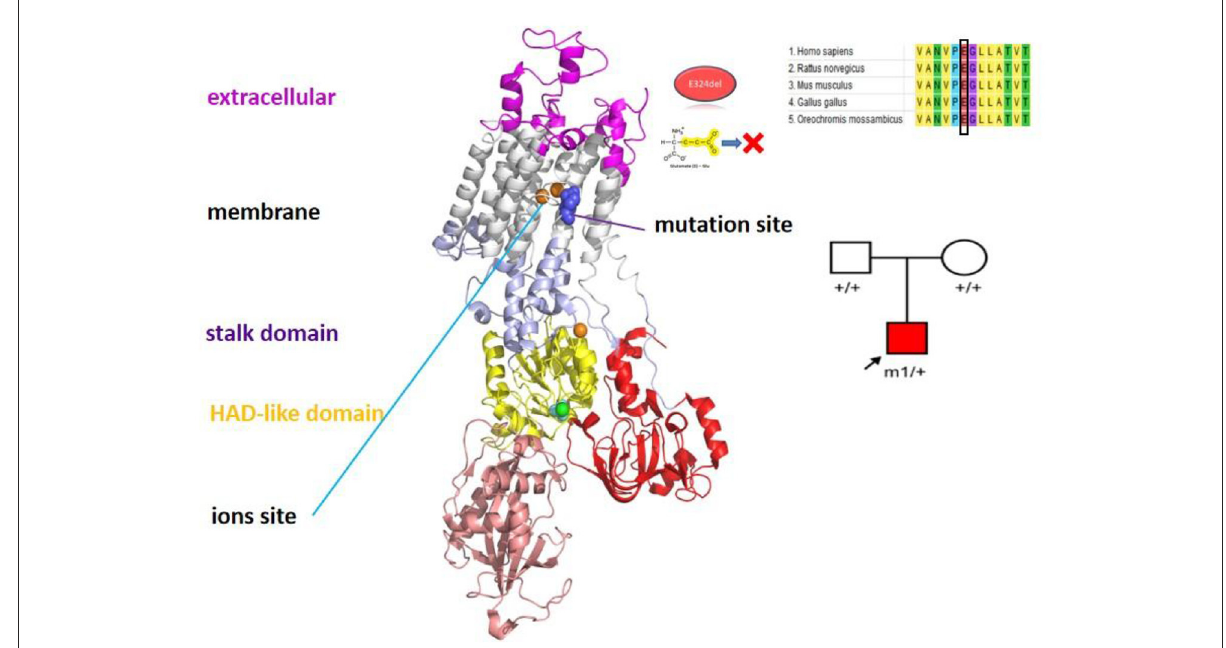
FIGURE3 The position of the mutation sites ATP1A3 p.E324del in the protein spatial structure.